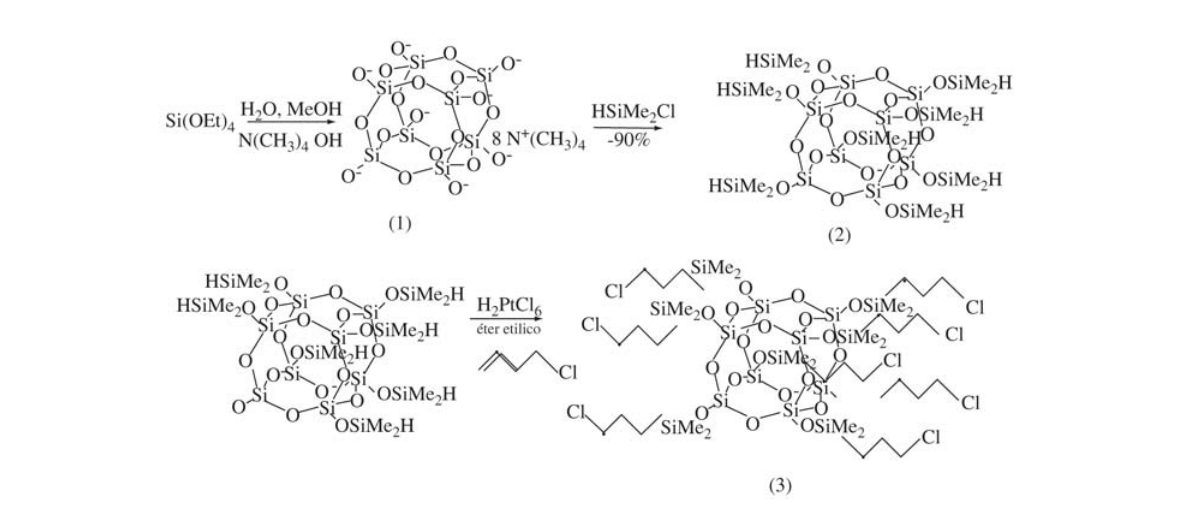
Figure 1. Scheme of synthesis of octakis (chloropropyldimethylsiloxy)